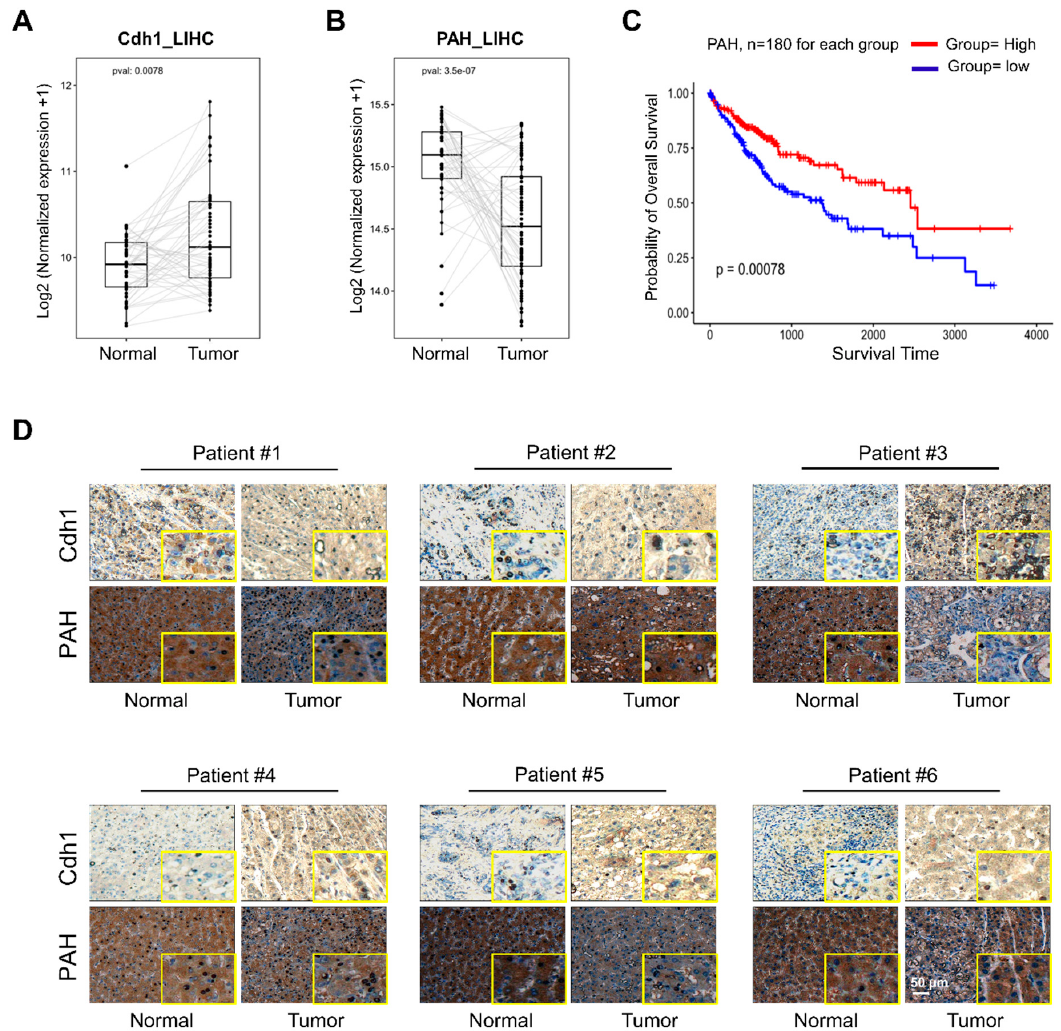
Figure 7. Association of APC / C Cdh1 and PAH in HCC. ( A ) Expression box plot showing significant differential expression of Cdh1 in normal vs. tumor tissues using normal-tumor matched liver cancer patient RNAseq data from TCGA. p value < 0.05 was considered to be statistically significant. ( B ) Expression box plot showing significant differential expression of PAH in normal vs. tumor tissues using normal-tumor matched liver cancer patient RNAseq data from TCGA. p value < 0.05 was considered to be statistically significant. ( C ) Kaplan–Meier survival curves. Liver cancer patients were divided into two groups based on PAH expression pattern, and the overall survival data from the high and low groups were used for the Kaplan–Meier analysis. p value < 0.05 was considered to be statistically significant. ( D ) Representative immunohistochemical staining of endogenous PAH and Cdh1 in human liver (Tumor) and non-neoplastic tissue (Normal) (inset shows location of threefold magnified regions) Scale bar = 50 µm.